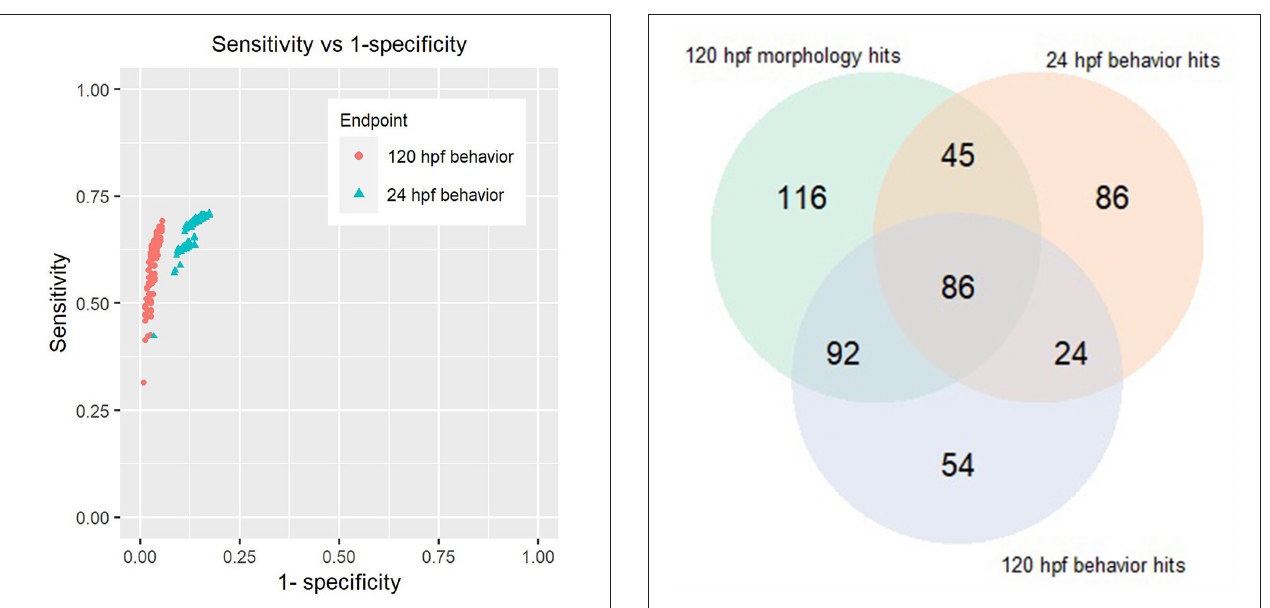
FIGURE 5 | Venn diagram comparing hits made using behavioral assays when subjected to BMD modeling to those made using morphology screen. TABLE 1 | Showing performance evaluations of the combined assay (24 hpf and 120 hpf behavior, and mortality) and detailed morphological screen. Concentration PP